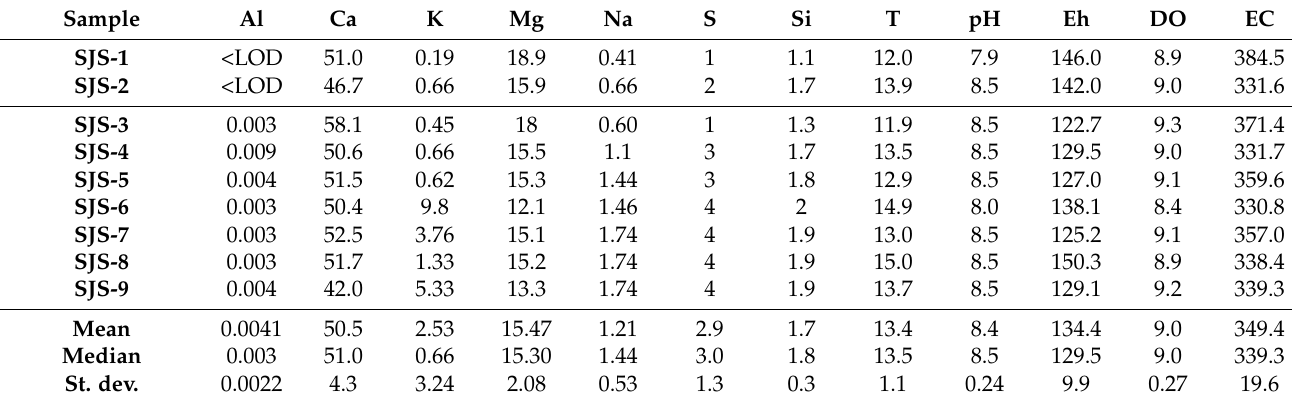
Table 3. Concentrations of major elements (mg/L) and physico-chemical characteristics of surface